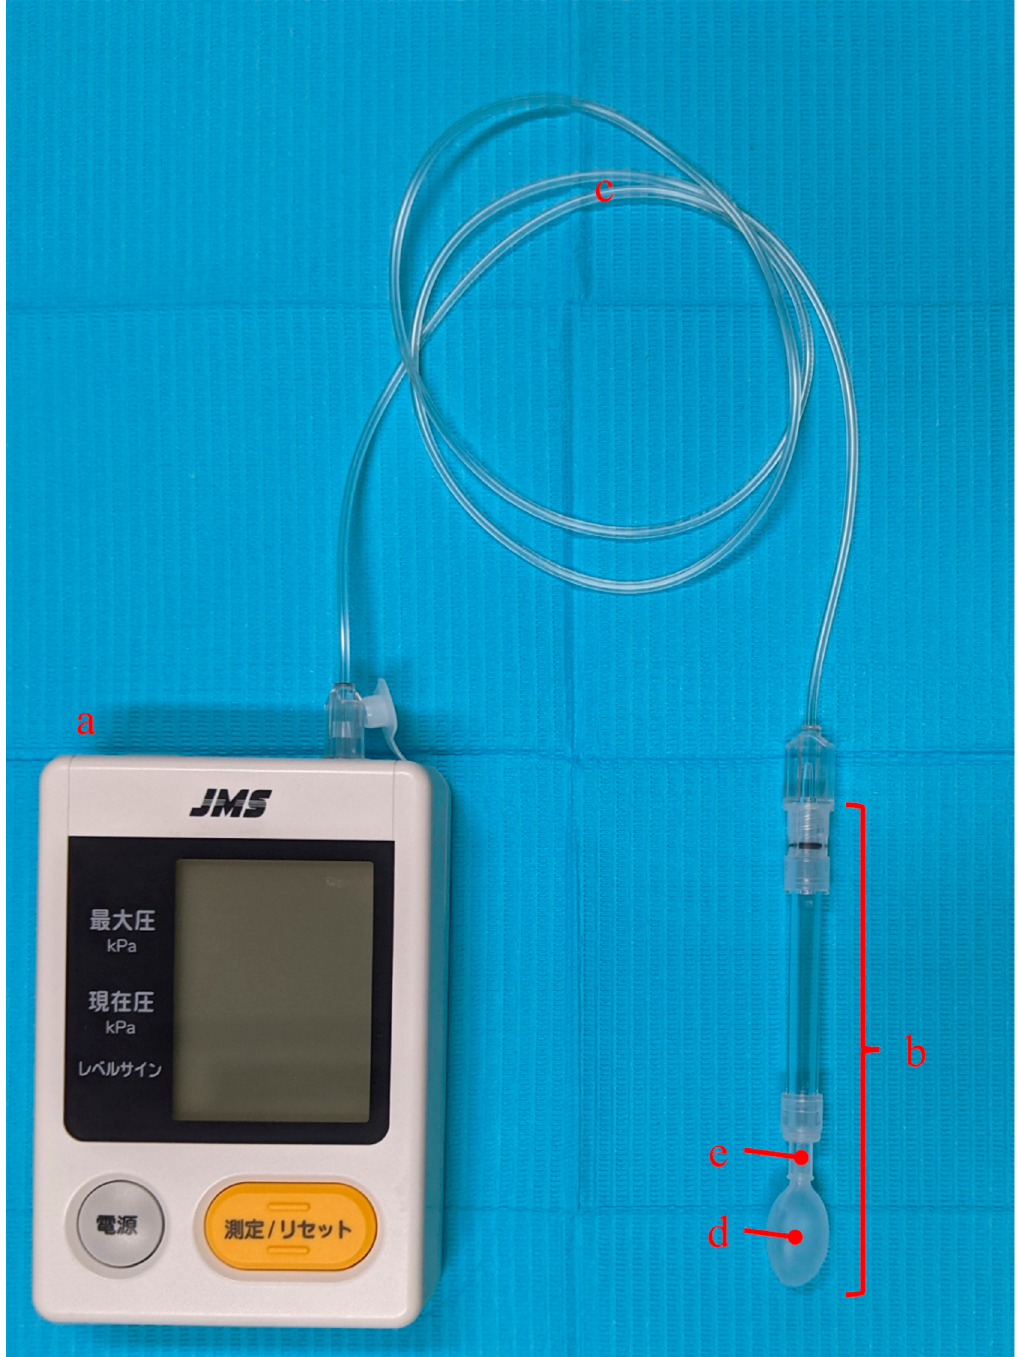
Figure 1. JMS tongue pressure measuring device (TPM-01, JMS Co., Ltd., Hiroshima, Japan). a: main body, b: probe, c: connecting tube, d: balloon, e: plastic